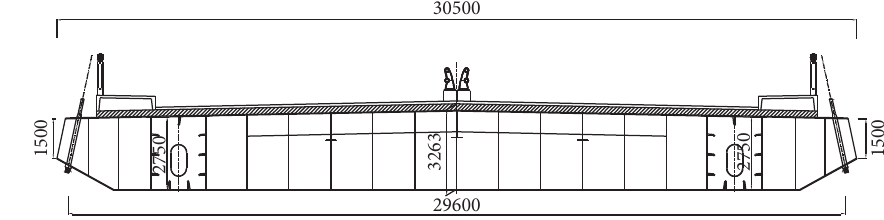
Figure 2: Cross section of the stiffening girder (dimensions are in mm).